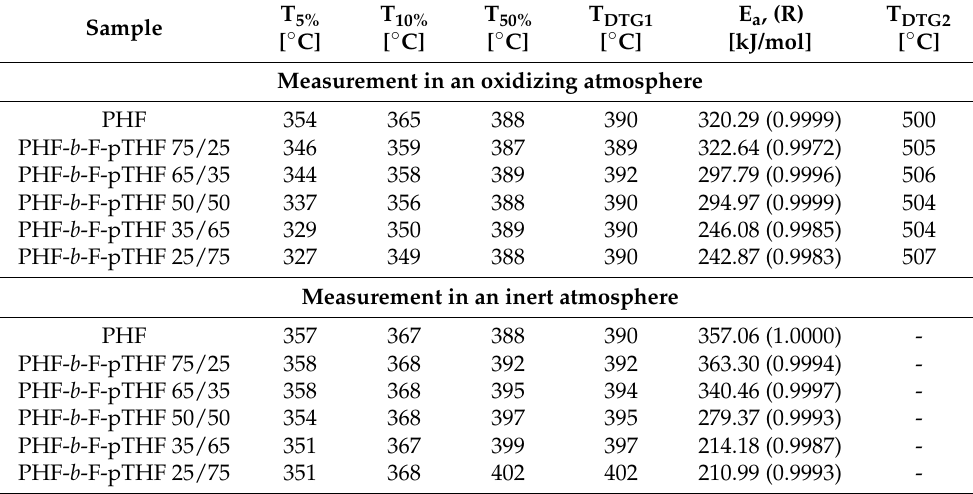
Figure 10. Mass loss (TG) and derivative of mass loss (DTG) curves for PHF-b-F-pTHF copolymers measured in an oxidizing atmosphere (air) ( a ) and in an inert atmosphere (argon) ( b ) at the heating rate 10 °C/min. Table 4. TGA data: temperatures of 5%, 10%, and 50% mass loss, the temperatures corresponding to the maximum of mass losses (T DTG1 and T DTG2 ), activation energies (E a ) and correlation coefficient in linear regression (R) in an oxidizing and an inert atmosphere.